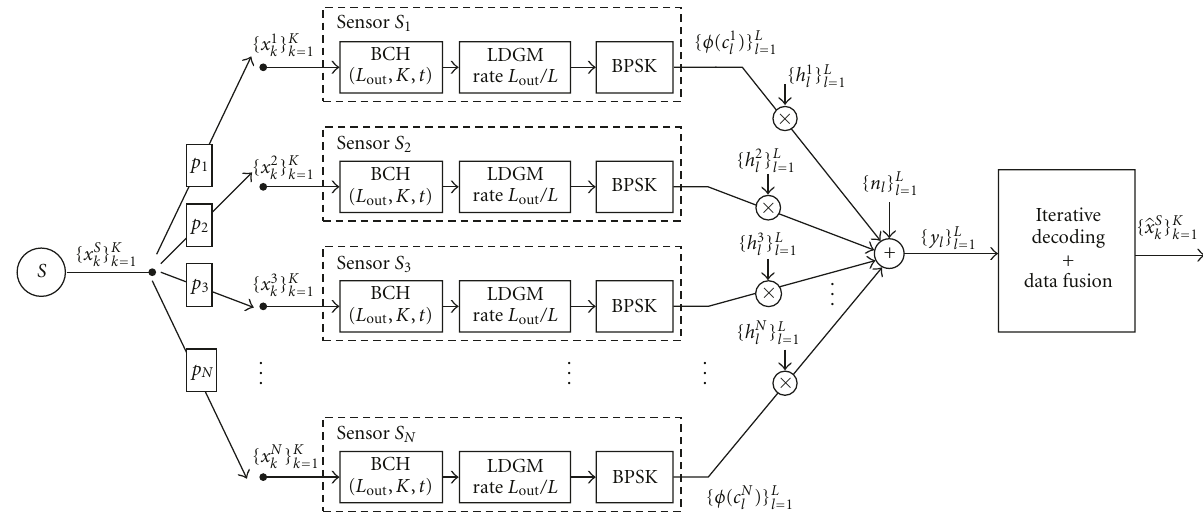
Figure 2: Block diagram of the considered